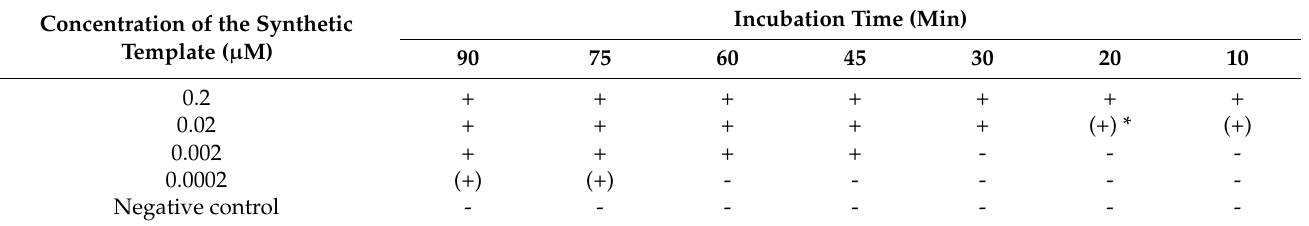
Table 3. Limit of detection (LOD) for RT-HDA combined with LFA using a synthetic template. Concentration of the